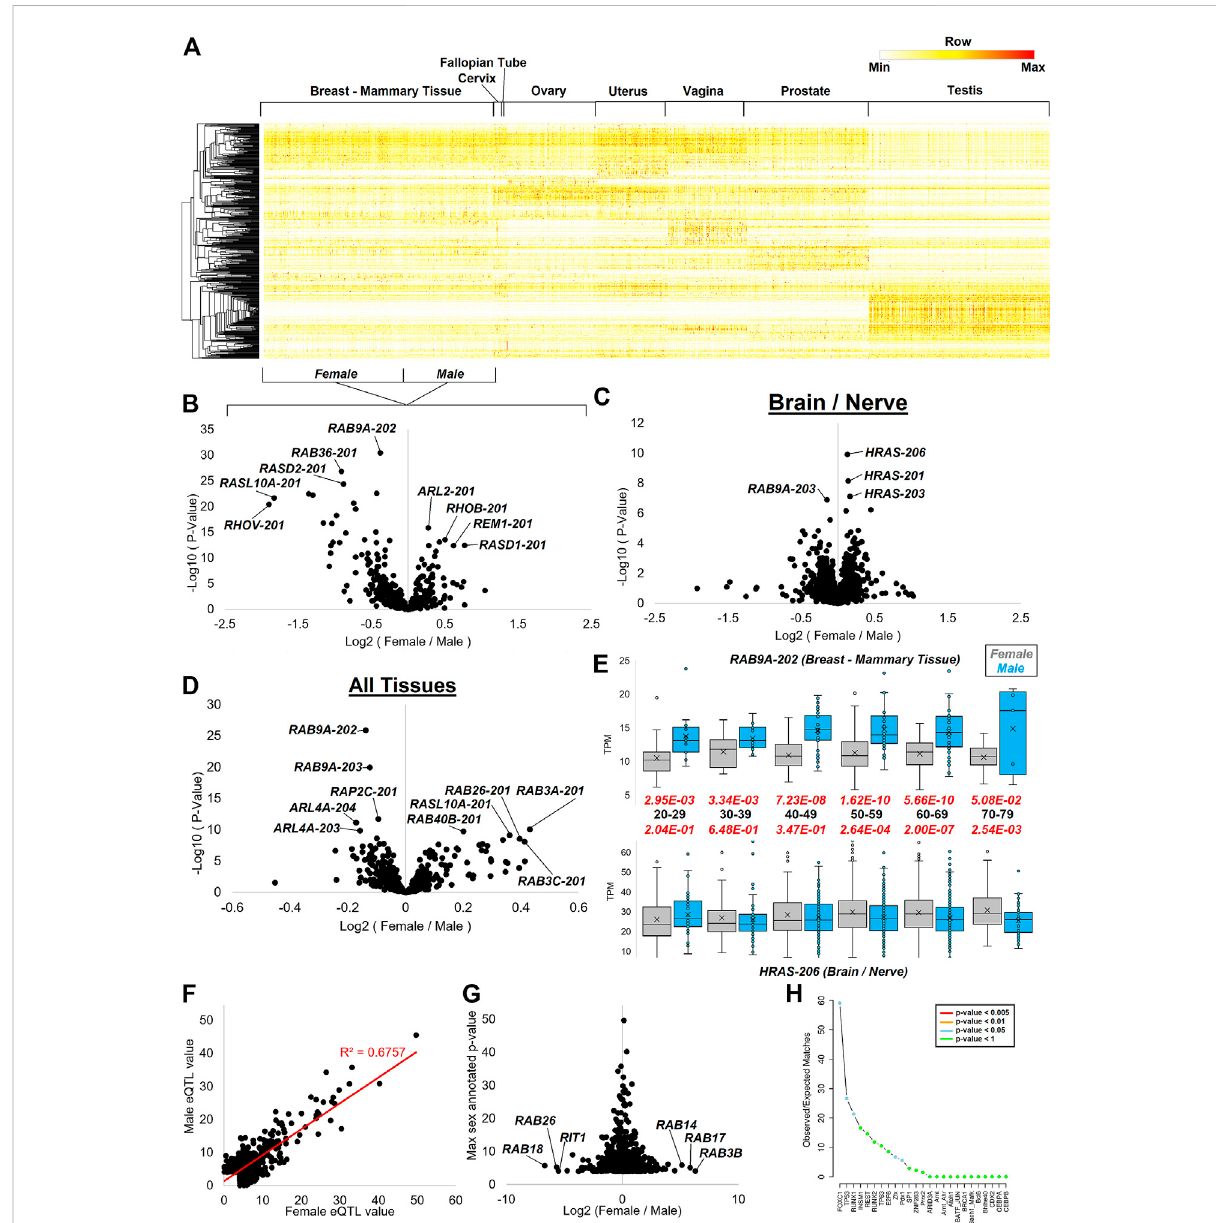
FIGURE 12 Splicing dynamicswithin reproductive datasetsand sexdifferences. (A) Heatmapofallsmall GTPase isoformsfor tissues withsexdifferencesin GTEx. Mammary breast tissue is the only one with both male and female data marked on the bottom for the grouping. Coloring is based on the z-scoreforeachgene,withthemiddlelevelinyellowandthehighestinred. (B – D) Volcanoplotwiththelog2foldchangeoffemalevs.males( x -axis) relative to the -log10 p -value of female vs. male ( y -axis) shown for mammary breast tissue (B) , multiple brain and neural datasets (C) , and all tissues (D) ofGTEx. (E) Representativeboxandwhiskerplotoftwotranscriptsshowingsexdifferencesatvariousages.Thetopshowsthe RAB9A-202 transcript, and the bottom shows HRAS-206 isoform. The black text in the middle is the age group with the red text the p -value of female (gray) vs. male (cyan). (F) GTEx annotated sex-based expression quantitative trait loci (sbeQTLs) for small GTPase genes, showing the female − log10 p -values onthe x -axisandmalevaluesonthe y -axis.Theredlineshowsthebest fi tlineandR-squaredcorrelation. (G) Thelog2foldchangeoffemalevs.male p -values ( x -axis) from panel F relative to the top annotated p -value. (H) SNP2TFBS analysis of the top variant with > 2 and < − 2 fold change in (G) , showing the enrichment of transcription factor binding sites in the SNPs identi fi